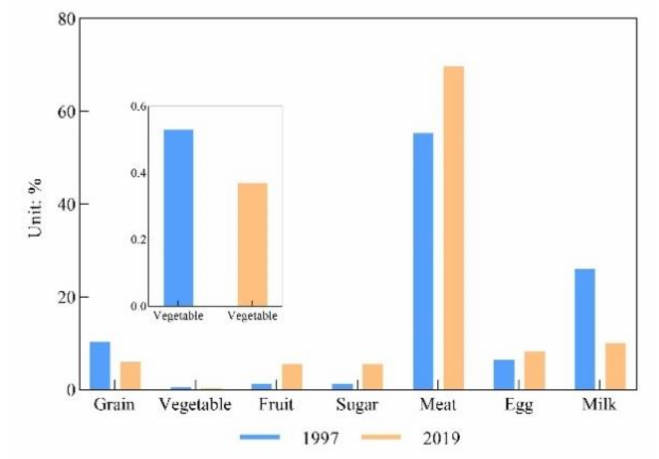
Figure 5. Food consumption patterns in Kazakhstan in 1997 and